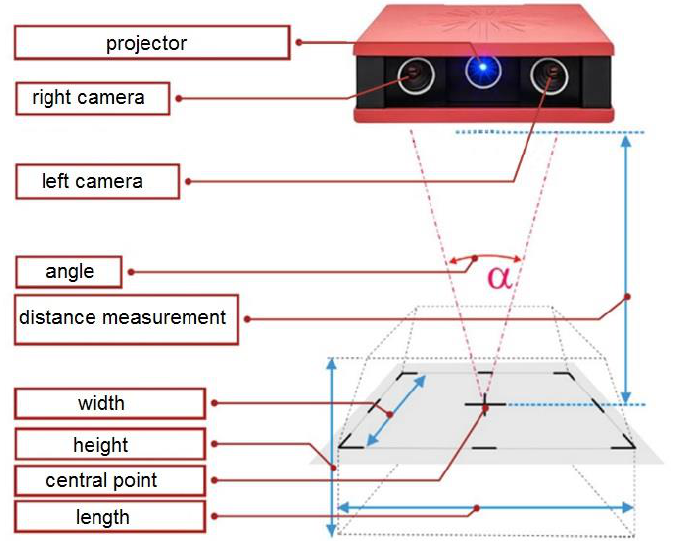
Figure 1. Atos Core — the idea of measurement.